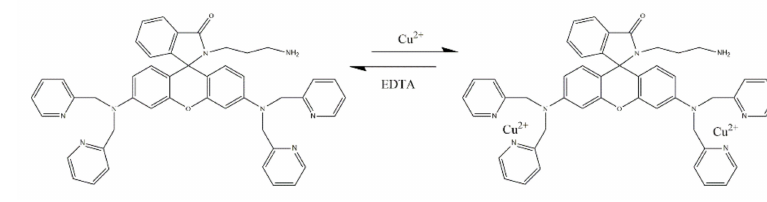
Figure 18. The proposed sensing process of NRG (Table 1, No. 23) [54].